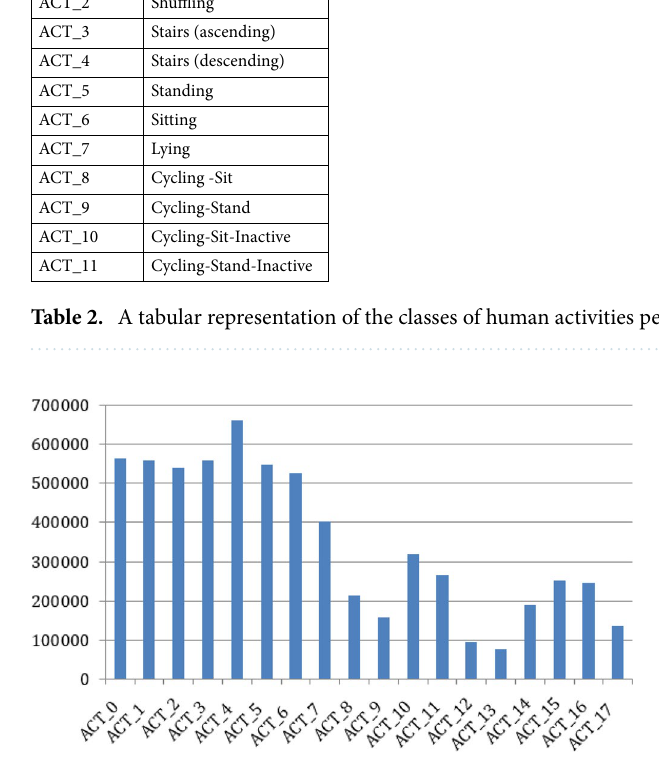
Figure 3. Class-wise distribution of human activities in the HARTH